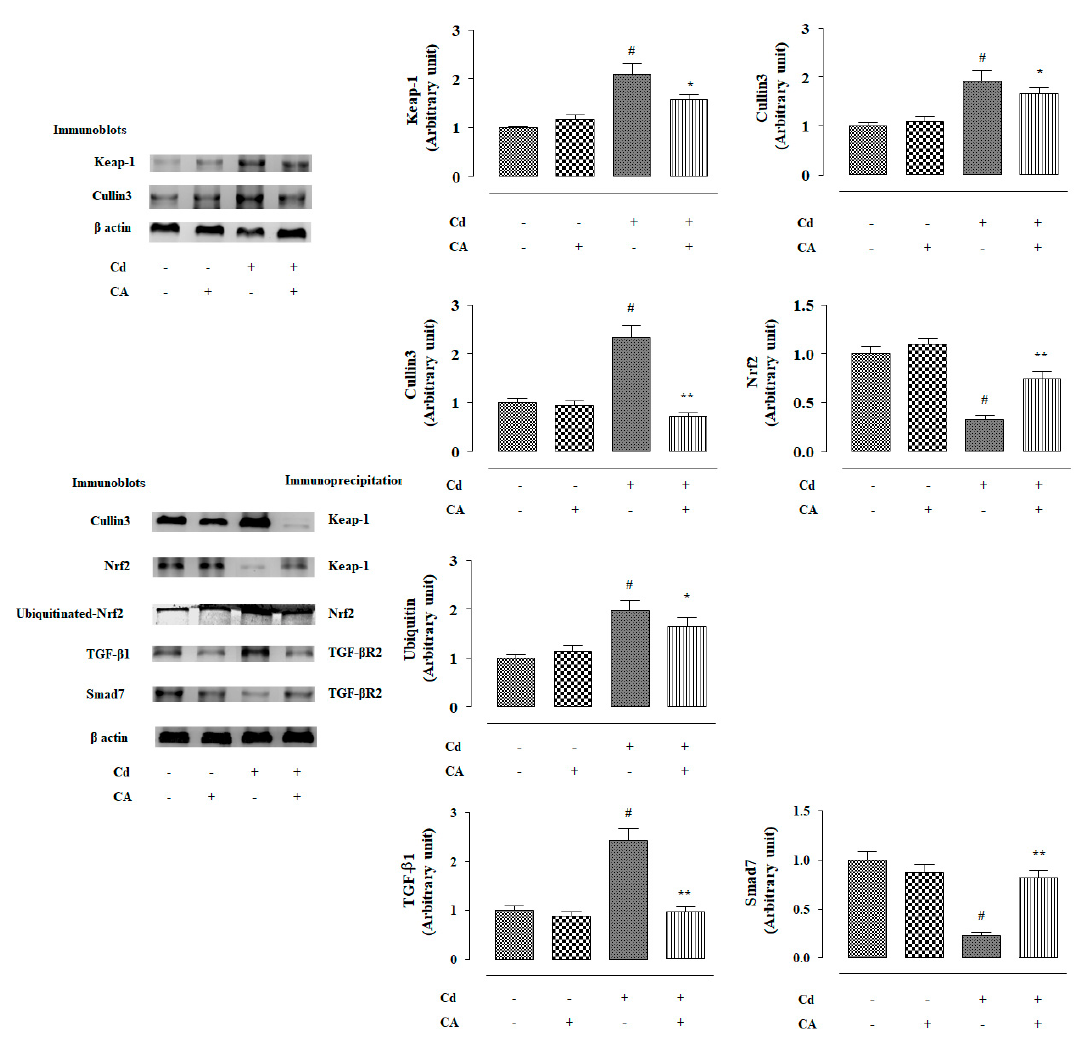
Figure 4. The e ff ects of CdCl 2 and / or CA on co-immunoprecipitation in vitro on NKE cells. The relative band intensities were measured and the intensity of normal control band was chosen as 1. β -actin served as loading control. Data are represented as the mean ± SD, n (number of plates) = 3. # Values significantly ( p < 0.01) di ff ered from the vehicle-treated group. * Values significantly ( p < 0.05) di ff ered from only the CdCl 2 -treated group. ** Values significantly ( p < 0.01) di ff ered from only the CdCl 2 -treated group.